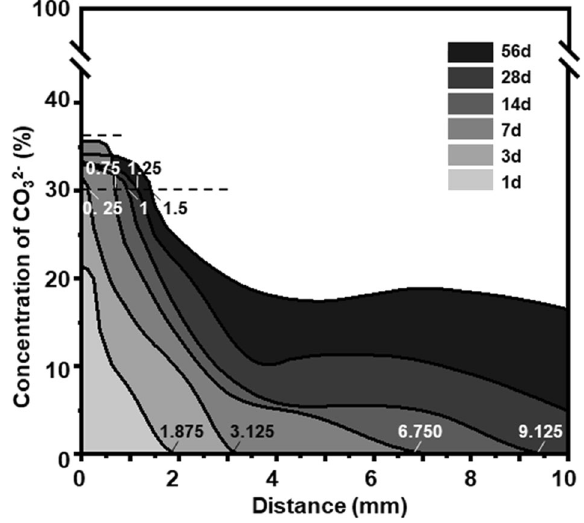
Fig. 4 The concentration of CO 32 − at different depth. An area graph illustrating the increase of the CO 32 − content with the time under accelerated carbonation against the distance to the exposure surface (the CO 32 − content at each depth is the averaged results of 8 points and the line was smoothed by Origin TM